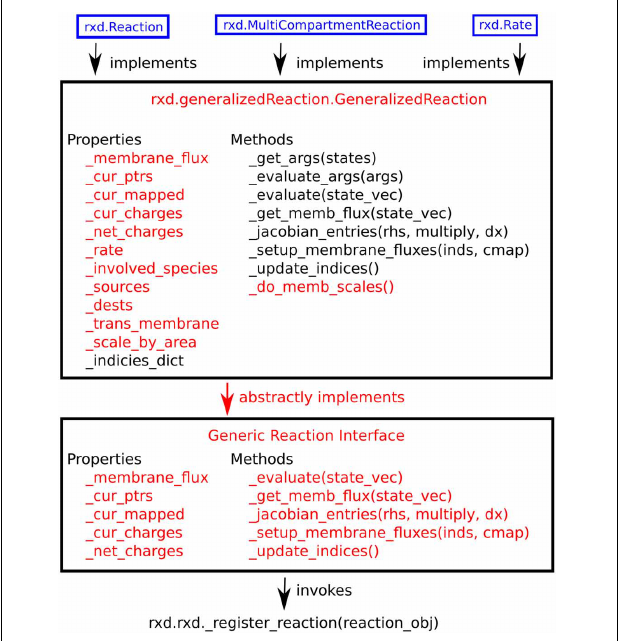
FIGURE 4 | Hierarchy of reaction classes. Red denotes abstract methods or properties, while black text indicates implemented ones. New schemes for specifying reaction kinetics may be implemented using the generic reaction interface, GeneralizedReaction, or any of the three reaction classes provided with rxd